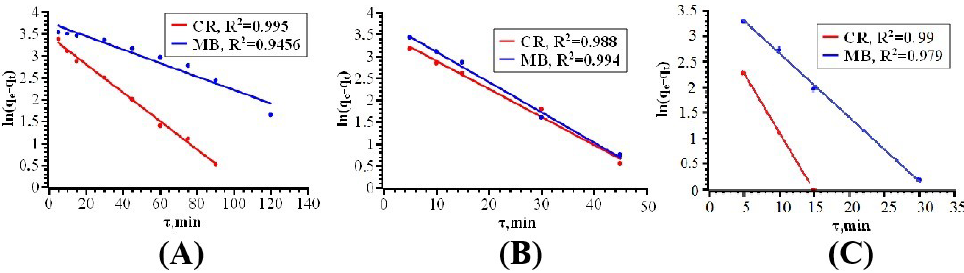
Figure 9. Kinetic model of adsorption in linearized form at 283 ( A ), 291 ( B ), and 308 K ( C ). Table 1. Best fit parameters for the dye adsorption onto the sorbent by the Langmuir and Freundlich models.